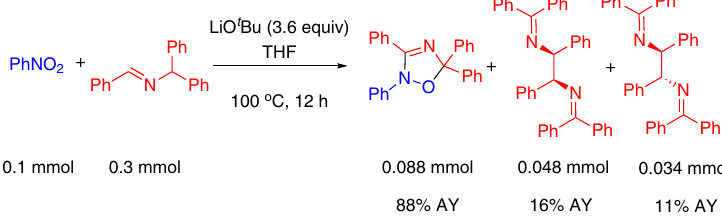
Fig. 7 Competition experiments and dimerization of the 2-azaallyl radical. a Competition between two nitroarenes. b Competing reaction pathways between arylation and oxadiazole formation. c Formation of the oxadiazole and diastereomeric dimers through 2-azaallyl radical coupling